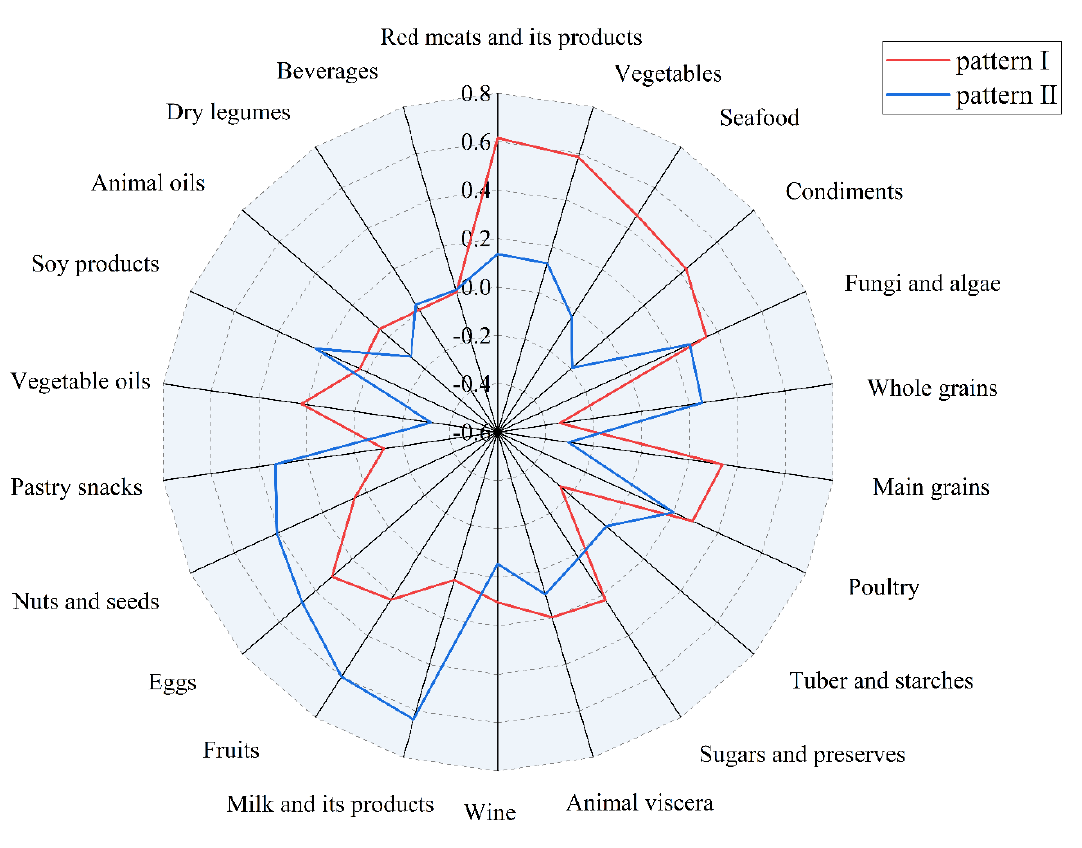
Figure 2. Radar plot of two dietary patterns by EFA.